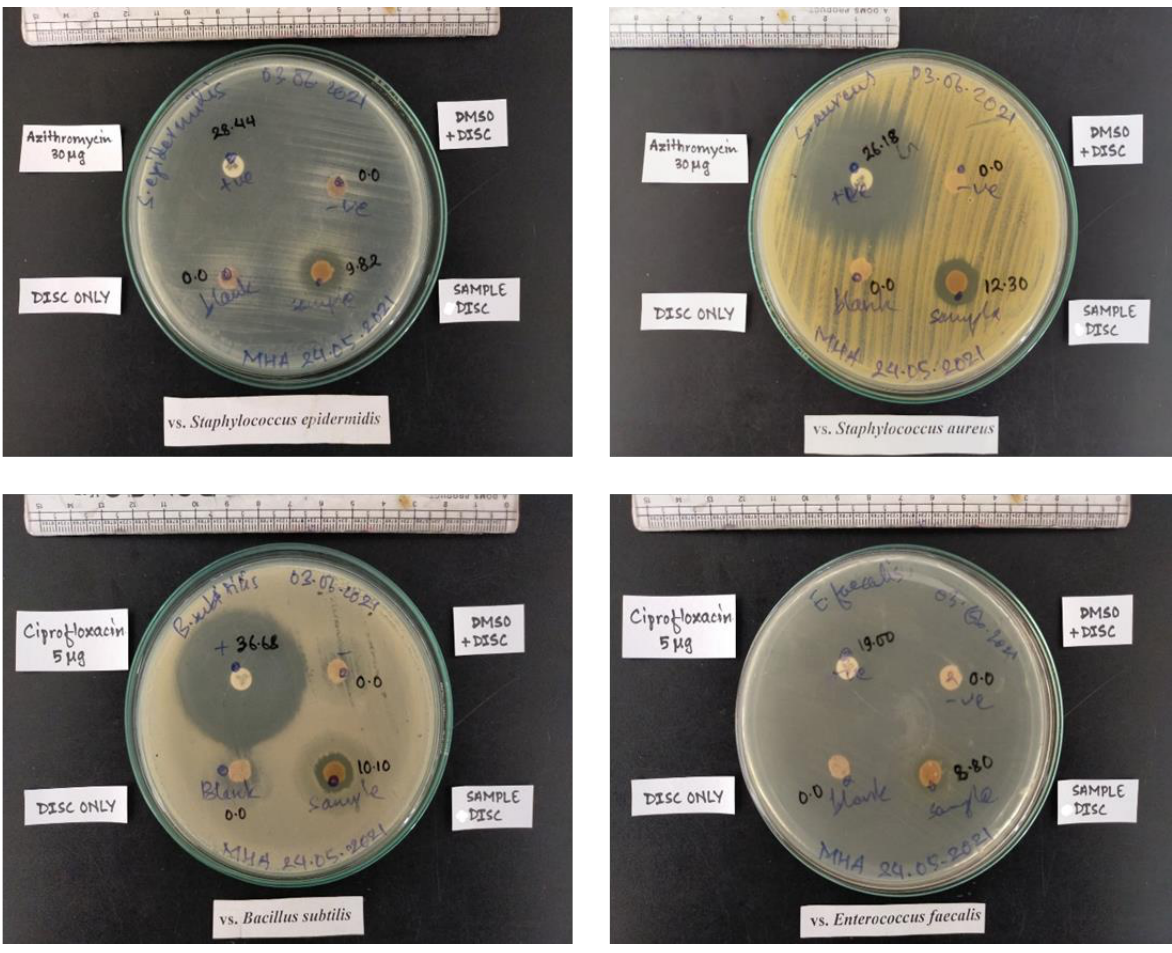
Figure 7. Antibacterial activity of different samples against different bacterial strains.